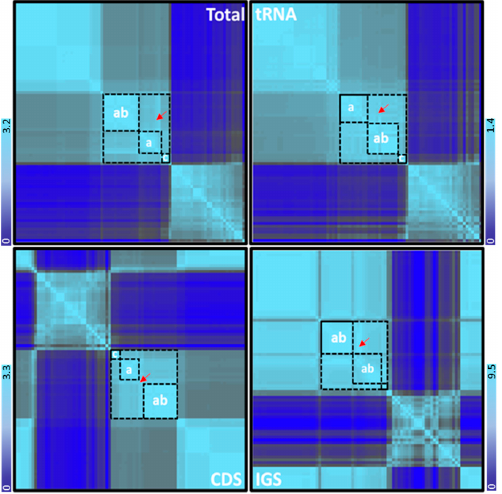
Figure 1. The heatmap represents the correlation between 78 cichlid species. The heatmap is constructed based on the matrix of complete mitochondrial genomes, tRNAs, CDS sequence, and IGS regions, and the phylogenetic analysis was performed by the maximum likelihood method. The haplotilapiine species are homogenized together in the same block, represented in the black box. The main black box is split into three small boxes—a: represents Oreochromis genus, ab: represents a mixed group of species (either Oreochromis , Sarotherodon , or both), and c: represents Coptodon genus. The red arrow represents an anomalous branch in the middle of the cluster. An increase of genetic diversity is indicated in light blue and a decrease in dark blue. The intensity of the color corresponds to the strength of the effect, referring to the median of the affected node.